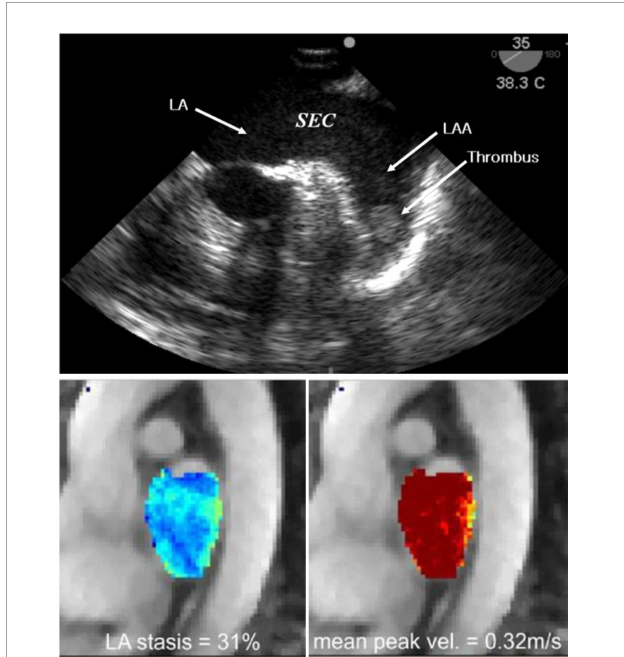
FIGURE2 Imaging of blood stasis. 2D TEE imaging of the LA and LAA. Spontaneous echo contrast (SEC) can be seen with a dense smoke near inside the LAA indicating presence of a thrombus (top) (123). 4D Flow MRI results indicating blood stasis within the LA cavity and peak velocities at the centre and walls of the LA (bottom)